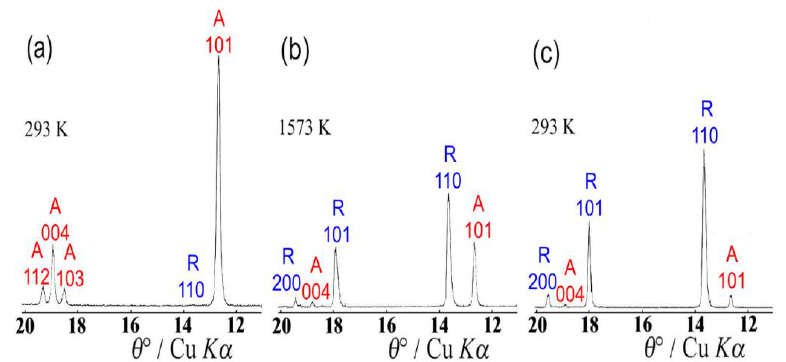
Figure 2. Characteristic parts of XRD patterns of the as-synthesized TiO 2 at ( a ) RT, ( b ) 1573 K, and ( c ) RT, after a complete heating and cooling cycle; A = anatase, R = rutile [19].